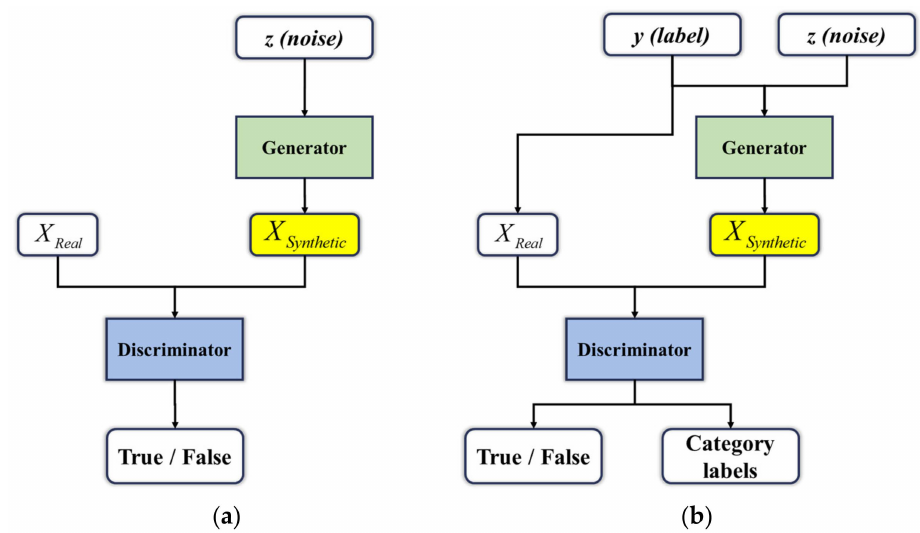
Figure 1. Typical architecture of ( a ) GAN and ( b ) the auxiliary classifier